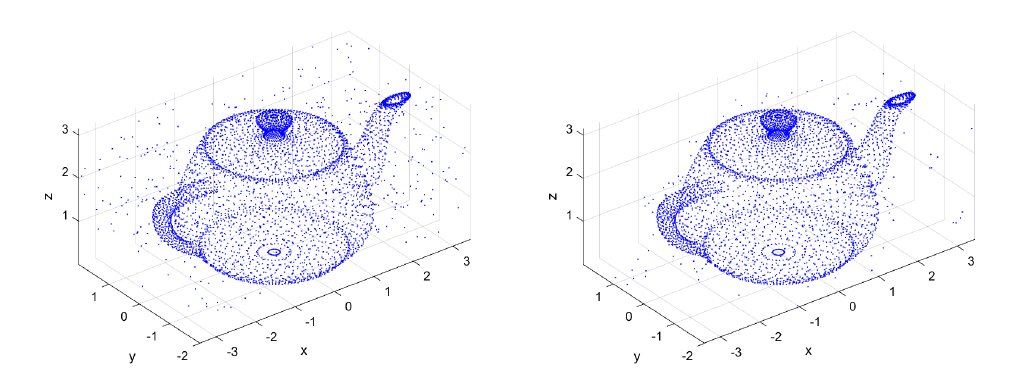
Figure 9. Point cloud after denoising based on Euclidean metric ( left ) and log-Euclidean metric ( right ).